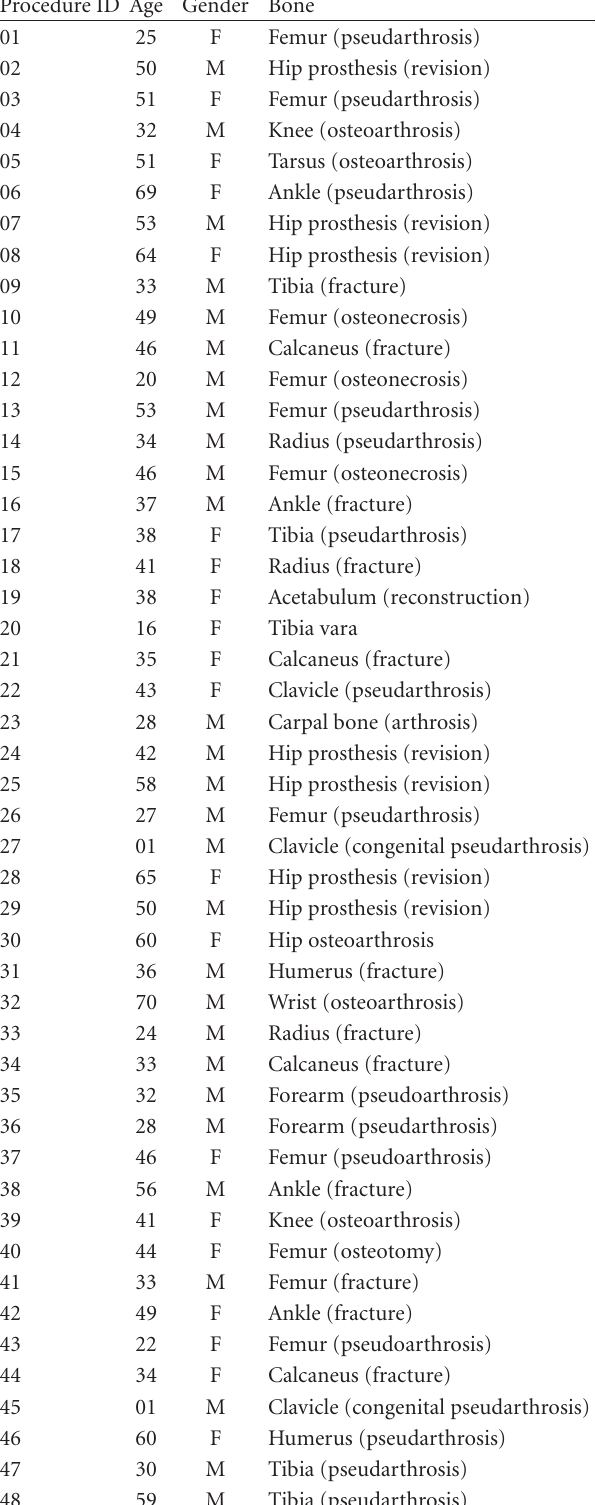
Table 1: Description of age, gender, and a ff ected bone of each patient. The initial diagnosis is described in parenthesis. F: female; M: